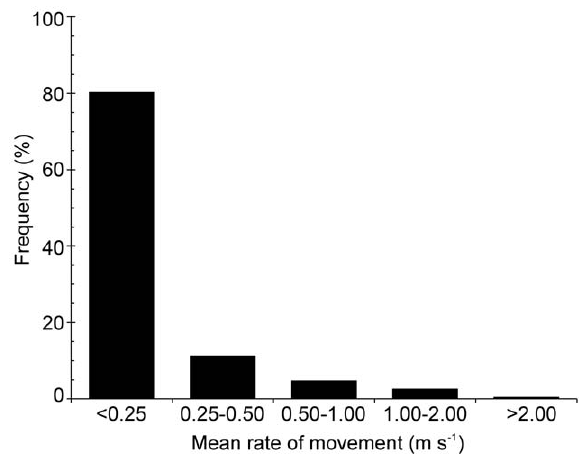
Figure 8. Distribution of tarpon mean rate of movement derived from 12-hour SPOT-tag location data.